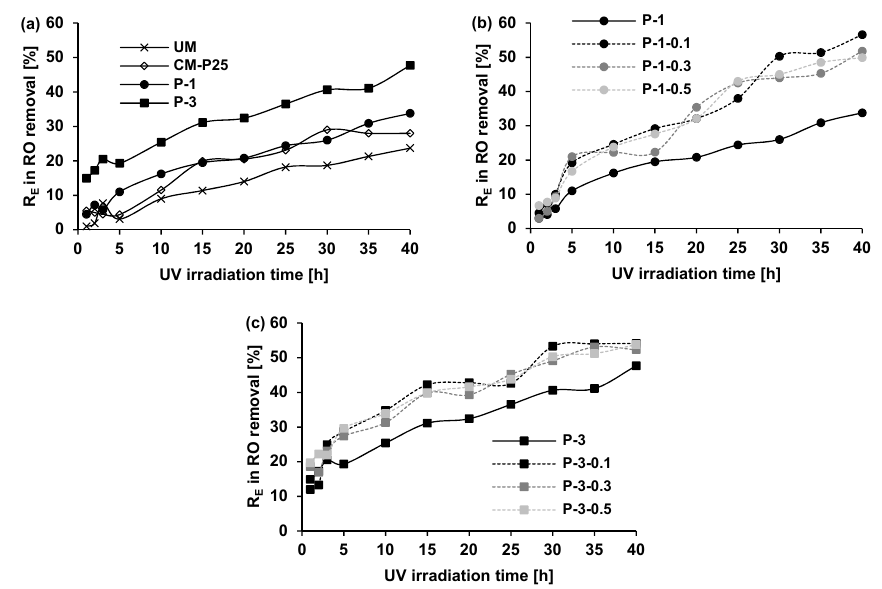
Figure 2. Photocatalytic degradation of Reactive Orange (RO) dye from gypsum surface as a function of UV irradiation time. ( a ) UM-unmodified gypsum plaster; CM-P25 gypsum plaster with 1wt%TiO 2 -P25; P-1, P-3 gypsum plaster with 1 and 3wt.% of TiO 2 /N; ( b ) P-1 gypsum plaster with 1 wt.% of TiO 2 /N; P-1-0.1, P-1-0.3, P-1-0.5 gypsum plaster with 1 wt.% of TiO 2 /N and 0.1, 0.3, 0.5 wt.% of glass fiber, respectively; ( c ) P-3 gypsum plaster with 3 wt.% of TiO 2 /N; P-3-0.1, P-3-0.3, P-3-0.5 gypsum plaster with 3 wt.% of TiO 2 /N and 0.1, 0.3, 0.5 wt.% of glass fiber, respectively.